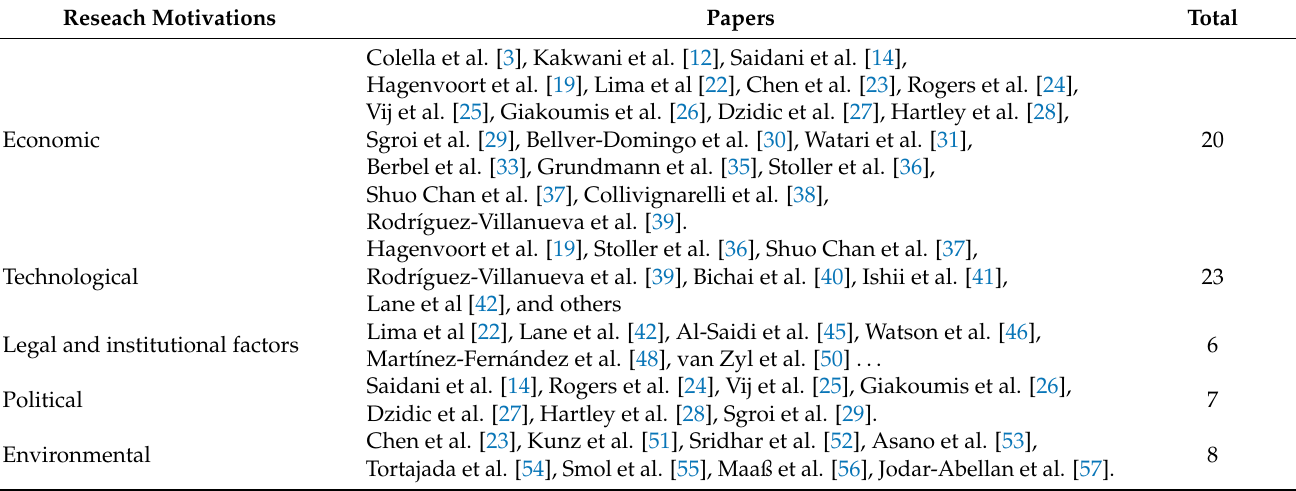
Table 3. Total documents per research motivation.